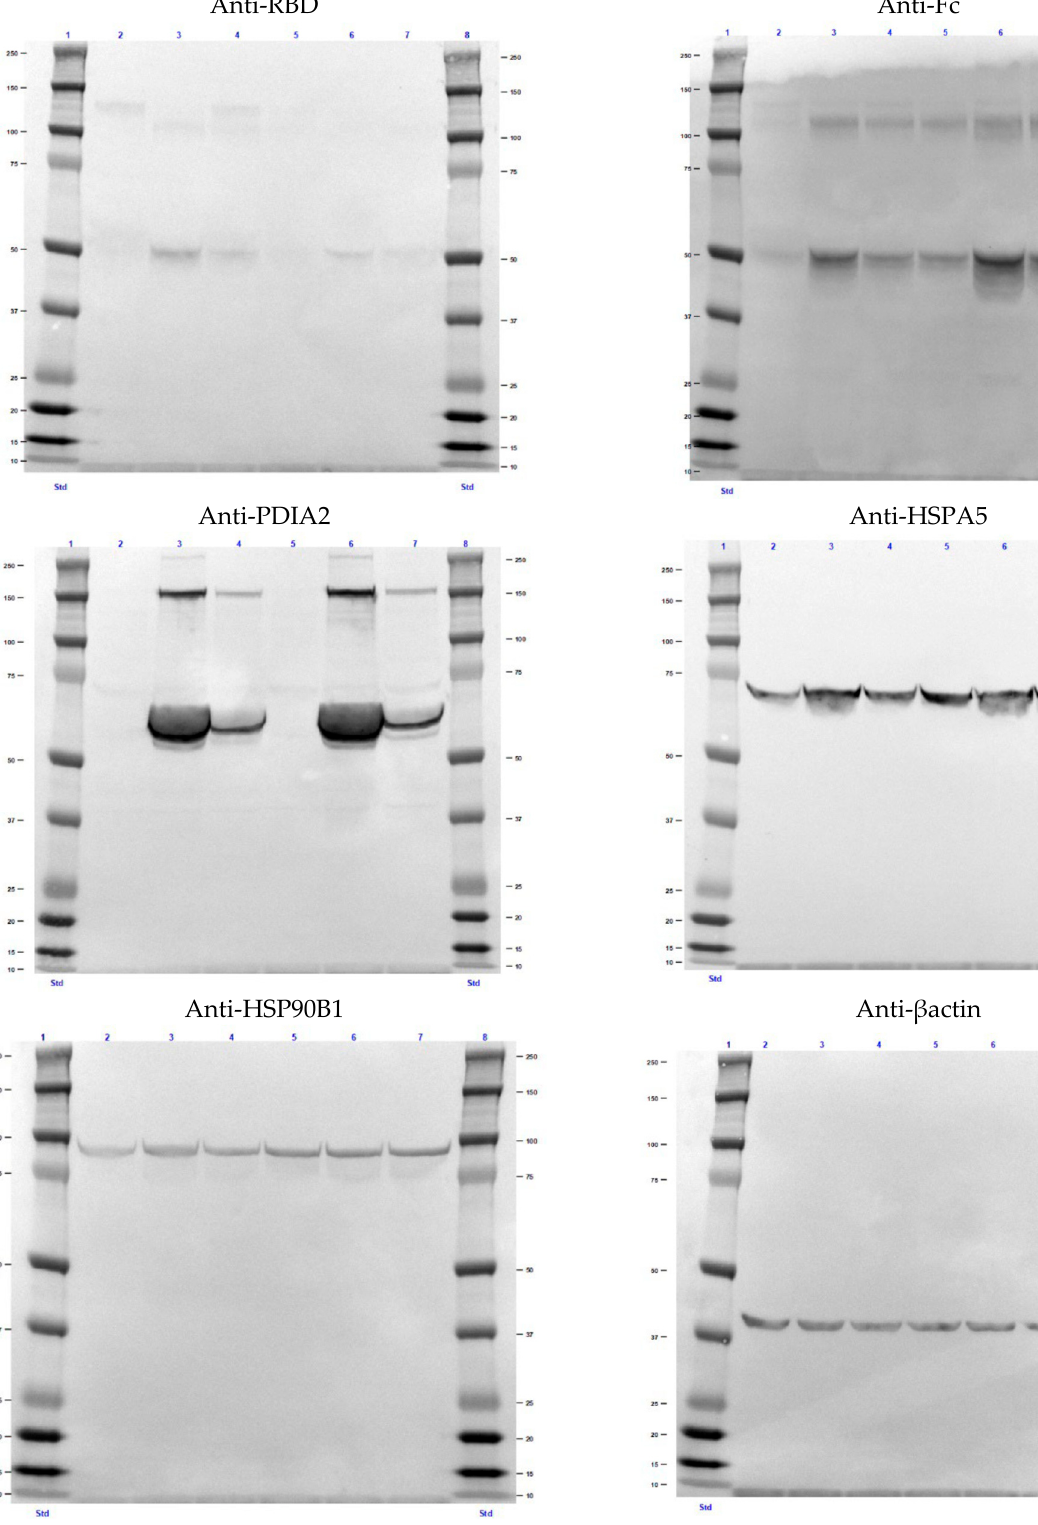
Figure A4. Uncropped western blot images shown in Figure 4b (intracellular proteins).